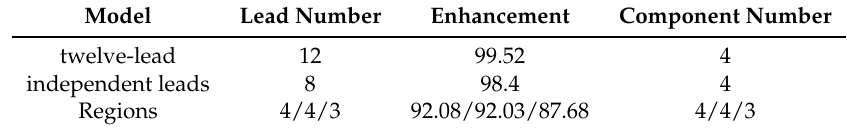
Figure 15. Different measurements for ICA over independent leads model. ( a ) Distribution of ρ RMSE coefficient for each independent component, values lower than zero represents cases where the RMSE measured over the ECG is greater than RMSE measured over the independent component. ( b ) ratio of fragmentation wave enhancement for each independent component, this ratio is computed as cases where the ρ RMSE value is greater than zero. ( c ) Cumulative ratio of fragmentation wave enhancement, this ratio is computed by joining the results of isolated independent components. Table 8. Summary table with the most relevant values of each proposed method based on